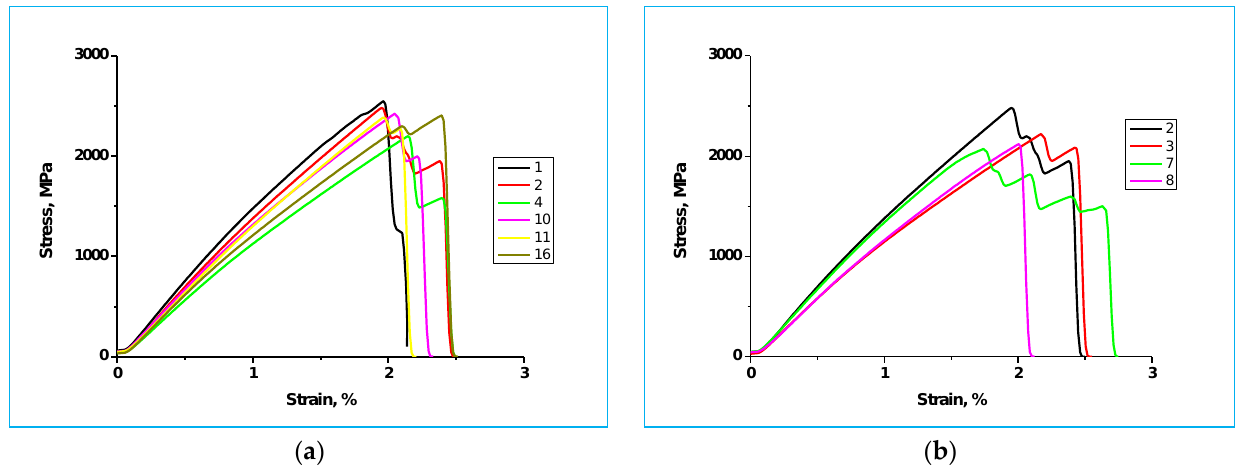
Figure 4. Stress–elongation curves for UHMWPE -orientated tapes. ( a ) entries 1,2,4,10,11, and 16; ( b ) entries 2,3,7, and 8 and Tables 1 and 2.